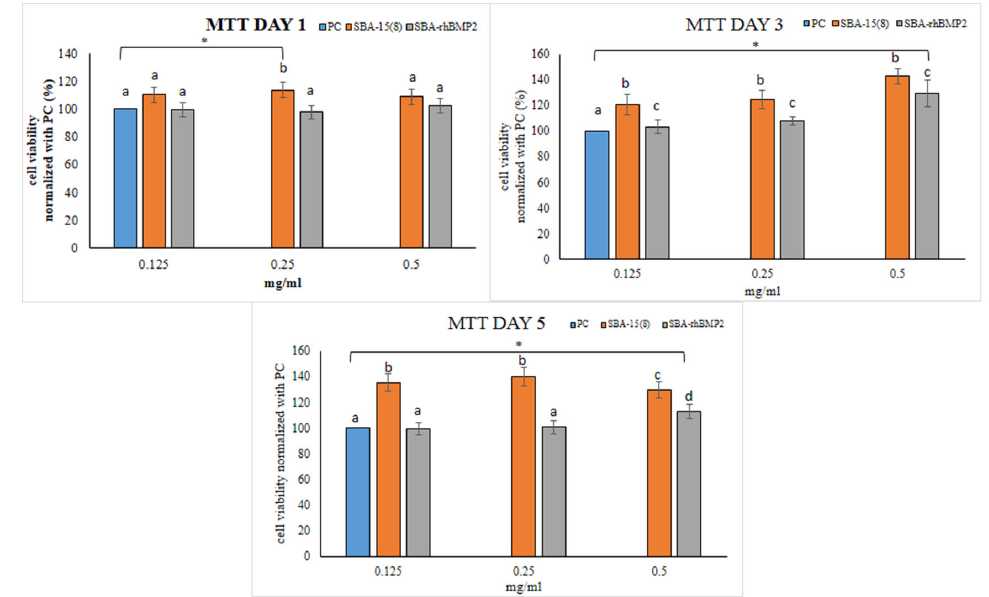
Figure 7. Cytotoxicity results of SBA-15 (8) MSNs at different concentrations (mg/mL). PC = plain cells without MSNs. The lines with * above bars indicate statistically significant differences ( p < 0.05) of cell viability between control (plain, untreated cells) and cells treated with different concentrations of MSNs (controls), while different letters above bars suggest statistically significant differences ( p < 0.05) of cell viability among the cells treated with different concentrations of MSNs. Same letters above the bars suggest that cell viability did not differ significantly among the specific MSNs and associated concentrations.